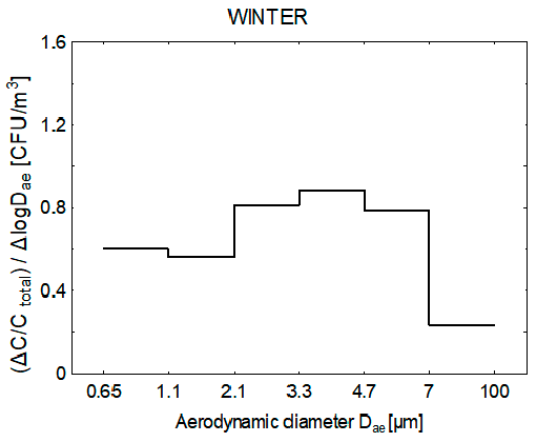
Figure 4. Size distribution of t bacterial aerosols in outdoor air in winter.